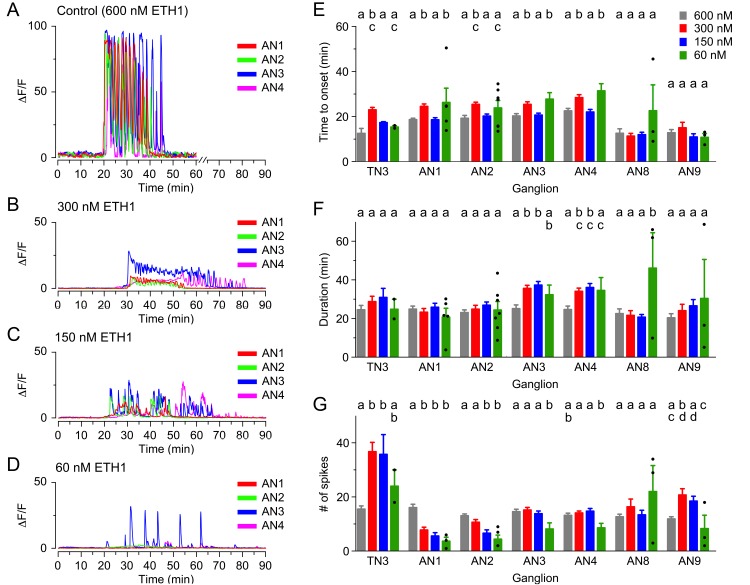
Calcium responses induced by different concentrations of ETH in CCAP neurons.(A–D) Pattern of GCaMP activity recorded from CCAP neurons in AN1-4 from control CNSs challenged in vitro with 600 nM (A), 300 nM (B), 150 nM (C), and 60 nM (D) ETH. Zero min indicates time of ETH challenge. (E–G) Quantitation of results, shown as described in Figure 3H–J. N = 10 for all preparations. Data are mean ± SEM. Different letters indicate statistically significant groups (p<0.05); one-way ANOVA, Tukey's post-hoc multiple comparison analyses. Actual p values can be found in Supplementary file 1. The responsiveness and amplitude of the responses were also affected; see text and Figure 3—figure supplement 1. Individual measurements have been superimposed on the summary histogram when <8 neurons showed a measurable response. Genotypes: all animals expressed GCaMP under control of Ccap-GAL4 (Ccap-GAL4 + UAS-GCaMP).